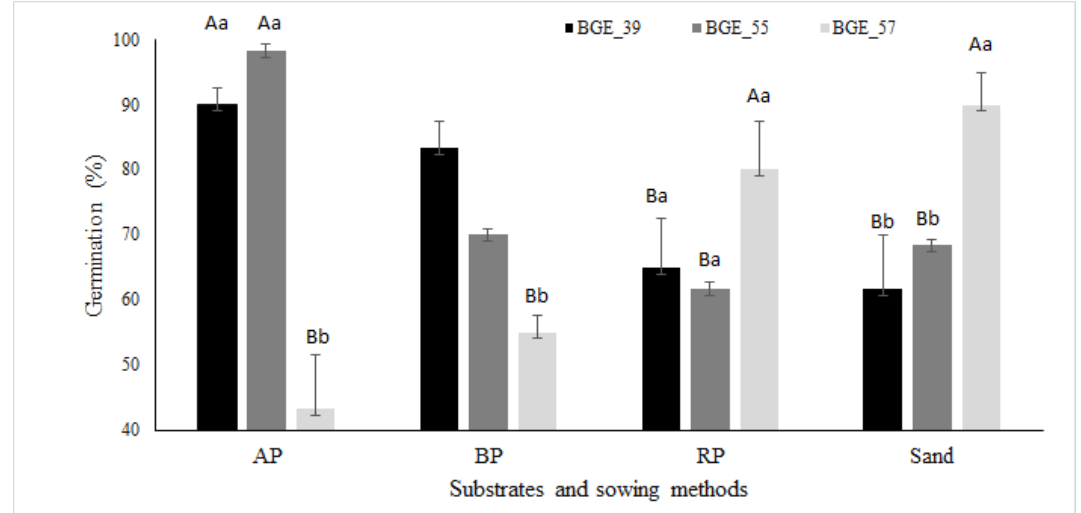
Figure 4. The germination rates of Eleusine indica (BGE 57) and E. tristachya (BGE 39 and BGE 55) seeds in sand, between papers (BP), Germitest rolled paper towel (RP) and over blotter paper (AP). Bars represented by the same upper-case letters, between the different substrates, and same lower-case letters, among Eleusine accessions, are not different by the Scott–Knott test and F test ( p < 0.05), respectively. Vertical lines represent the mean standard error.